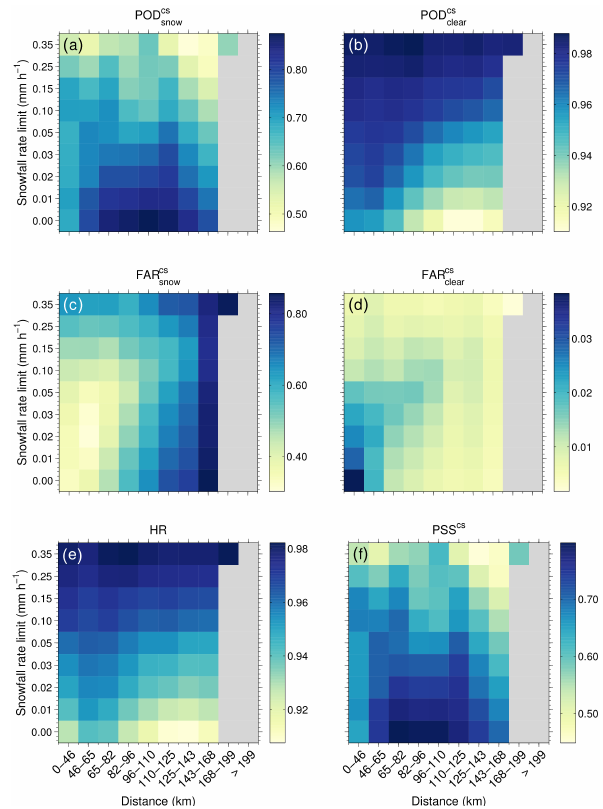
Figure 5. Statistical scores for CloudSat using Swerad as a refer- ence. The scores are shown as a function of distance to the nearest radar as well for different lower limits of the snowfall rate. The panels show the probability of detecting snow (a) , the probability of detecting clear conditions (no precipitation) (b) , false alarm rate of snow (c) , false alarm rate of clear conditions (d) , hit rate (e) , and Pierce’s skill score (f)